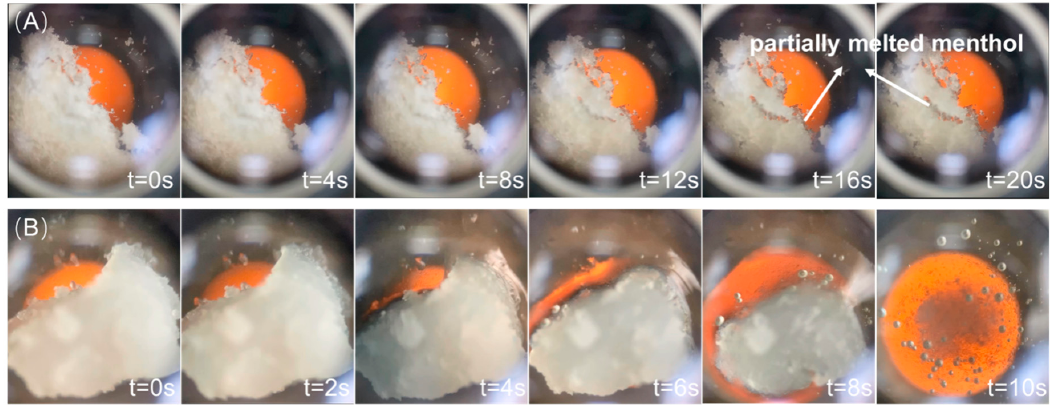
Figure 3. Time-lapse optical image showing the fragrance release behavior of ( A ) menthol-GG and ◦ ( B ) menthol-SM at 70 °C. ( B ) menthol-SM at 70